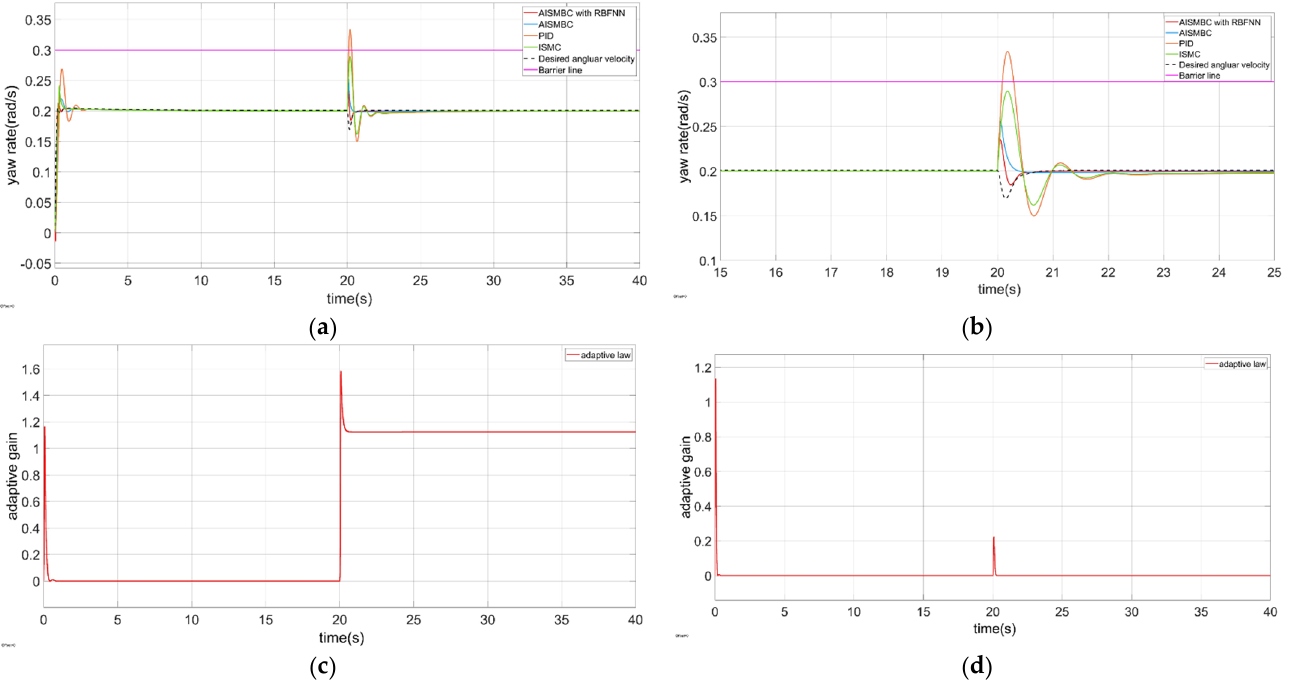
Figure 15. The results of the yaw angular velocity control with the step disturbance. ( a ) The results of the three control methods for the yaw angular velocity. ( b ) Local amplification of the yaw angu- lar velocity control results. ( c ) Adaptive gain of AISMBC. ( d ) Adaptive gain of AISMBC with RBFNN.